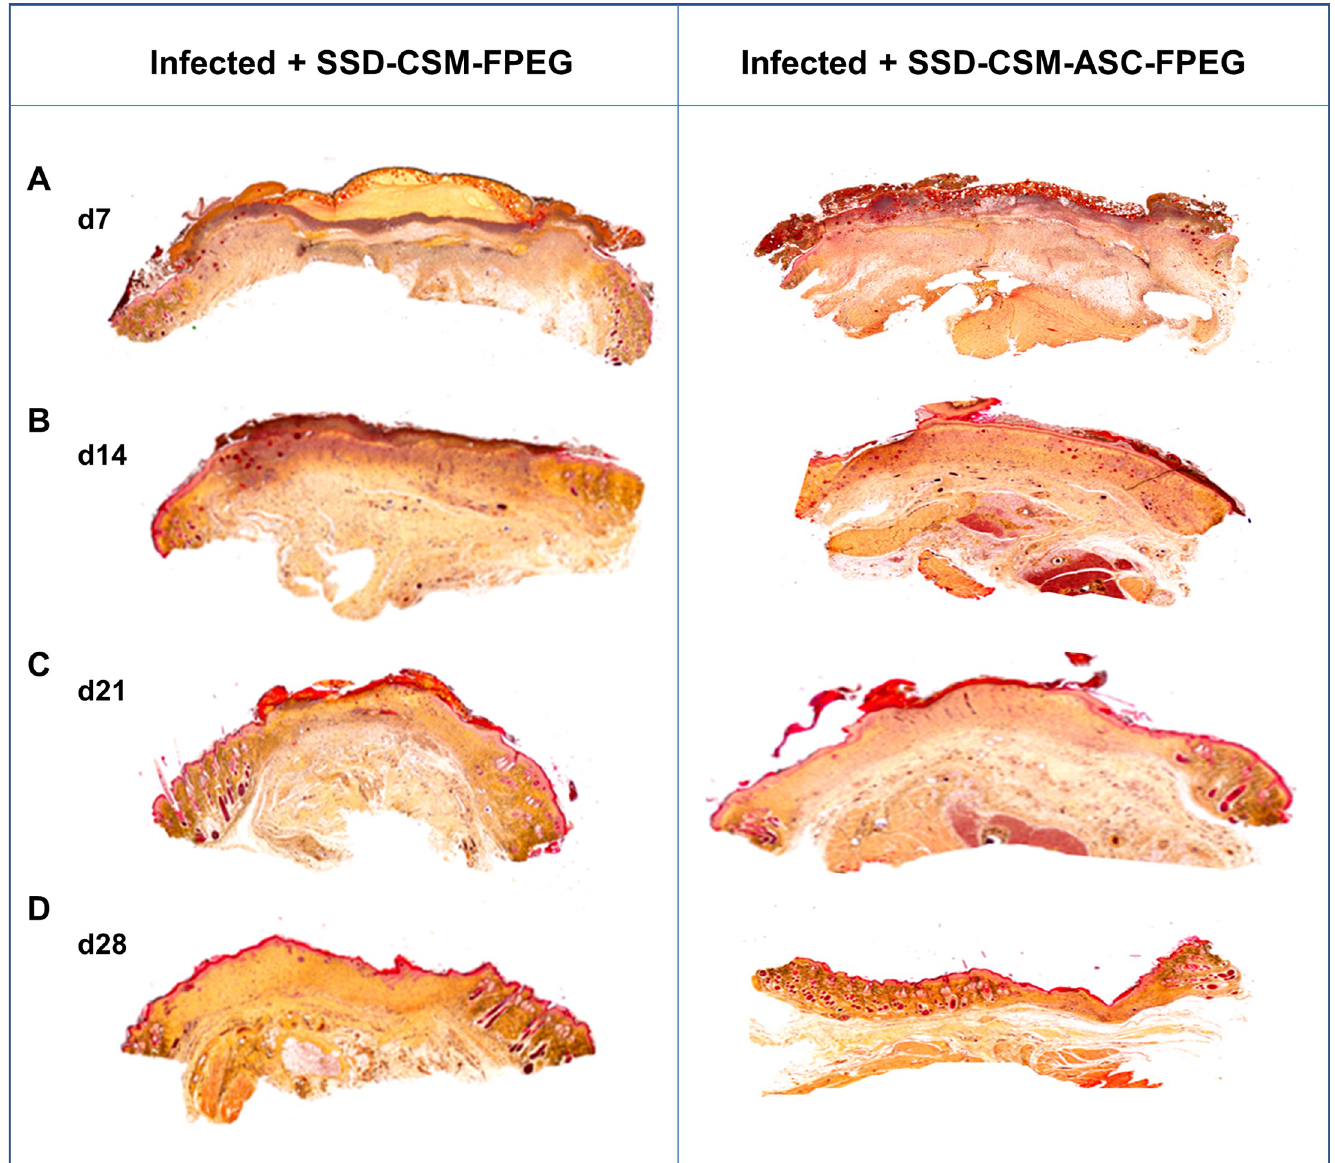
Fig 8. Wound closure characteristics. Representative Movatt’s pentachrome staining showing wound histology on (A) day 7, (B) day 14 (C) day 21 and (D) day 28. Interpretation of Pentachrome staining is as follows: blue: ground substance, mucin; bright red: fibrin; red: muscle; yellow: collagen and reticular fibers; black: cell nuclei. SSD-CSM-ASC-FPEG treated samples was observed to have a significantly thicker granulation tissue. ( n = 4).